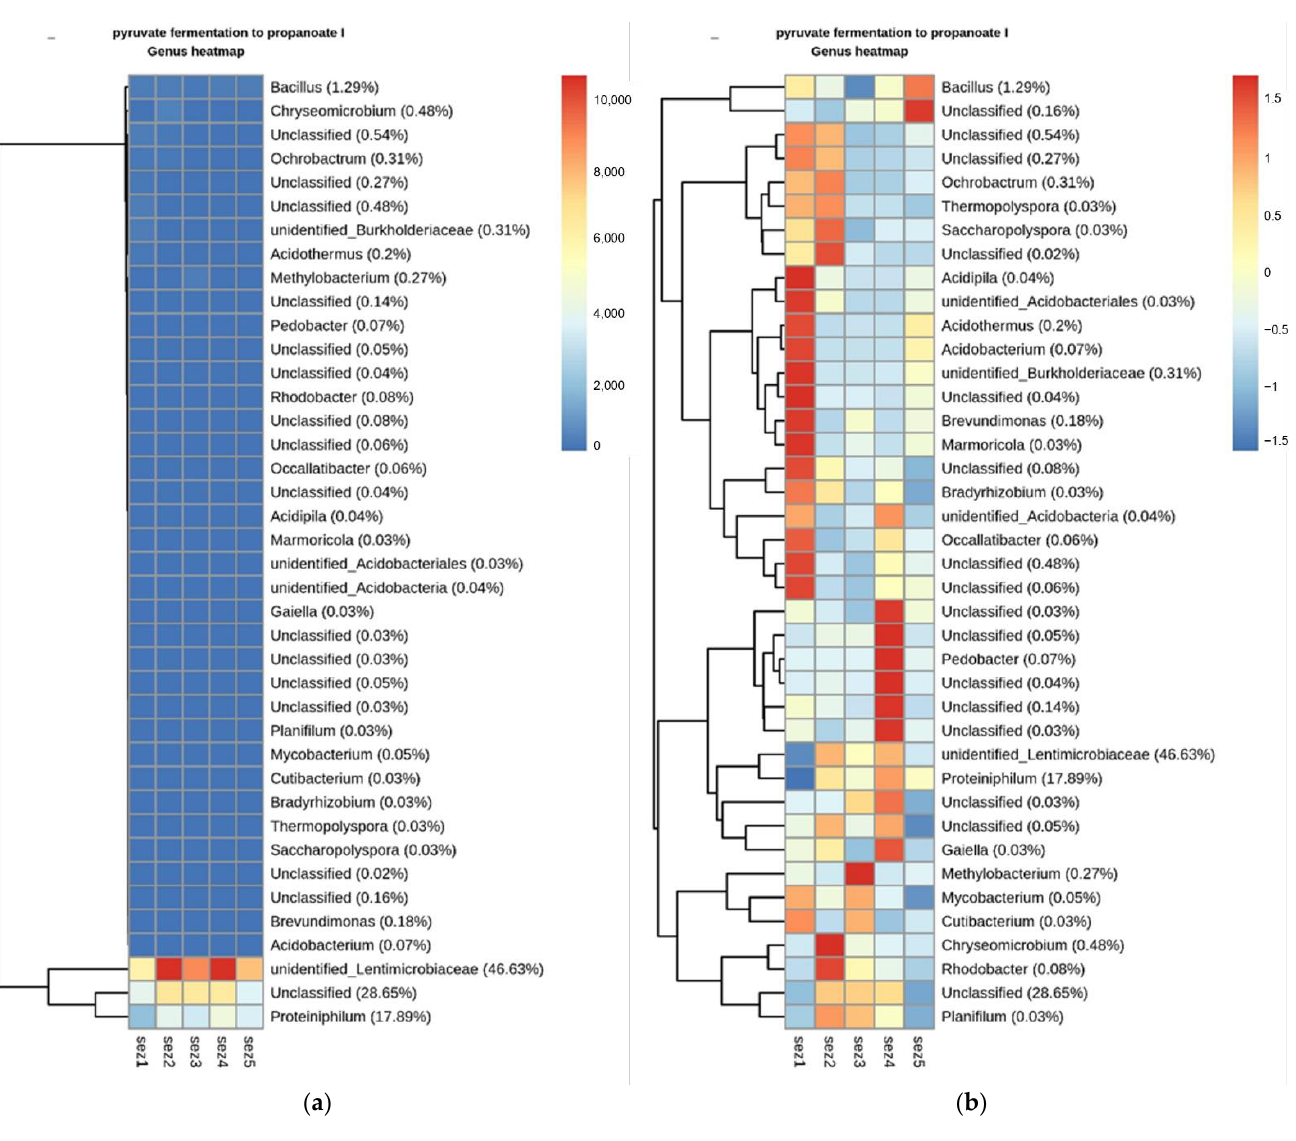
Figure A4. Functional heatmaps of pyruvate fermentation to propanoate I: ( a ) absolute counts and ( b ) autoscaled counts, aggregated at the genus level.